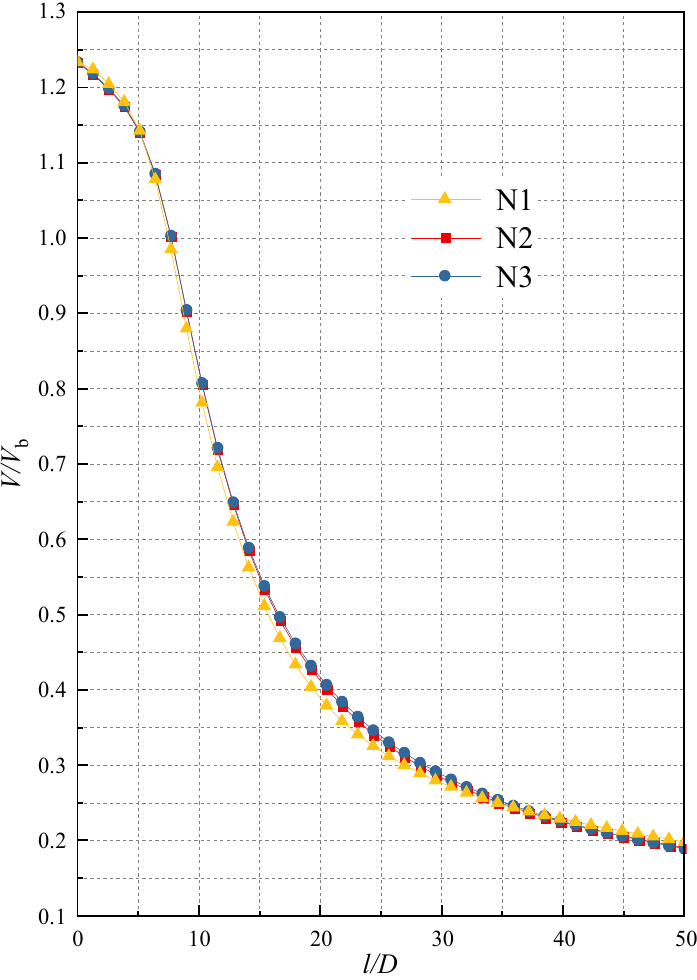
Figure 2. The distribution of the axial velocity V / V b of the jet for the different numbers of grids.